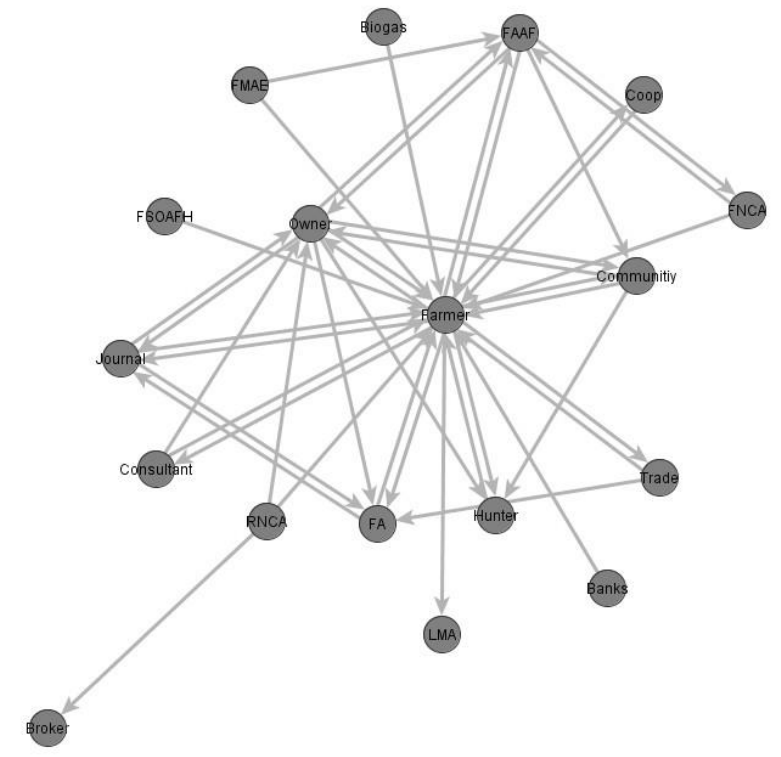
Figure A3.2. Local network when three and more links between actors were